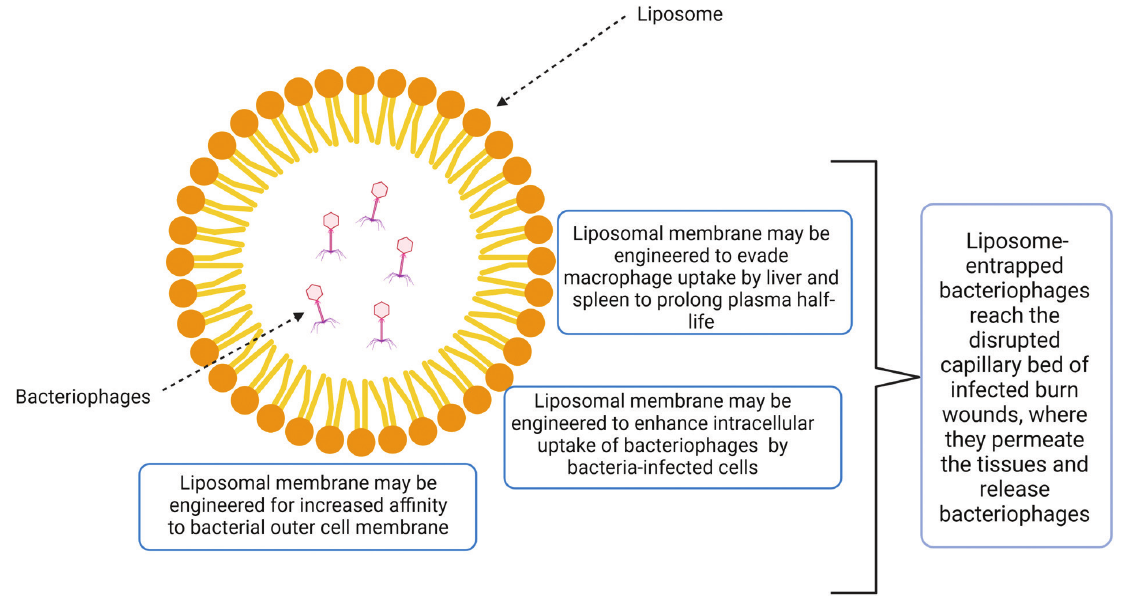
Figure 3. Possible mechanisms of enhanced antimicrobial activity of liposome-entrapped bacteriophages (LEBs). The chemical composition and structure of liposomes of LEBs may be engineered for polarity, size, and lipophilicity to evade macrophage uptake by liver and spleen to prolong the plasma half-life of bacteriophages, to enhance intracellular uptake of LEBs by bacteria-infected cells, and to increase affinity to bacterial outer cell membranes. Moreover, LEBs reach the disrupted capillary bed of infected burn wounds where they permeate the tissues and release